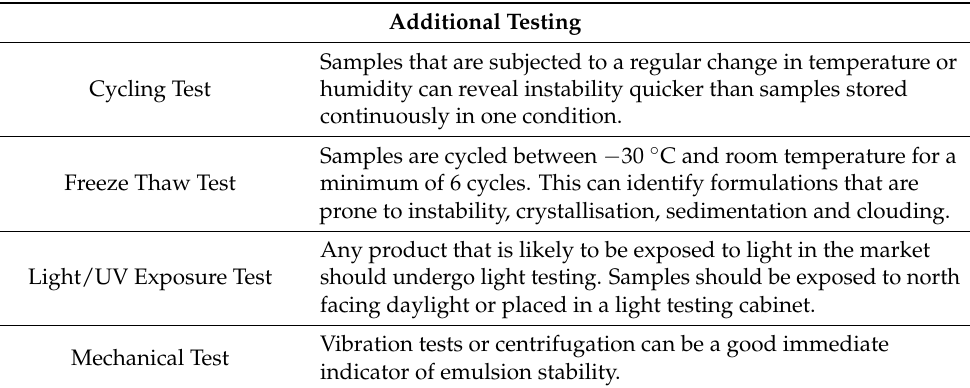
Table 2. Additional stability tests that may be necessary according to the IFSCC